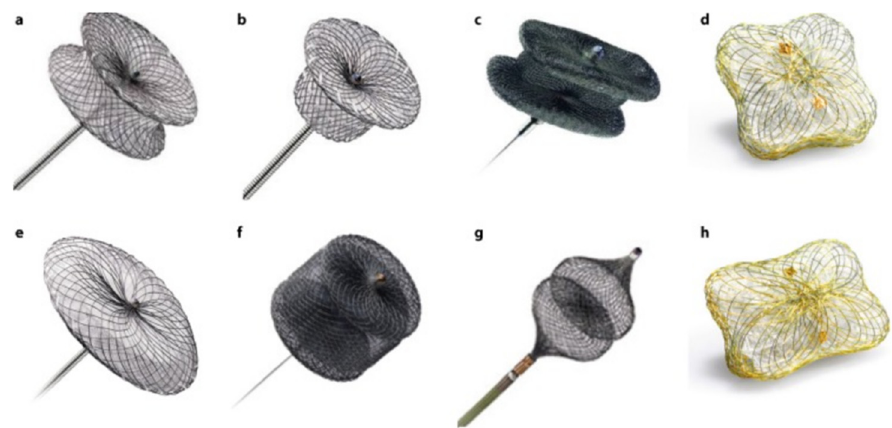
Figure 7. PVL closure devices. ( a ): Amplatzer Muscular VSD Occluder. ( b ): Amplatzer Duct Occluder. ( c ): Amplatzer Vascular Plug III. ( d ): Occlutech PLD (square-shaped design). ( e ): Amplatzer Septal Occluder. ( f ): Amplatzer Vascular Plug II. ( g ): Amplatzer Vascular Plug IV. ( h ): Occlutech PLD (rectangular-shaped design) .